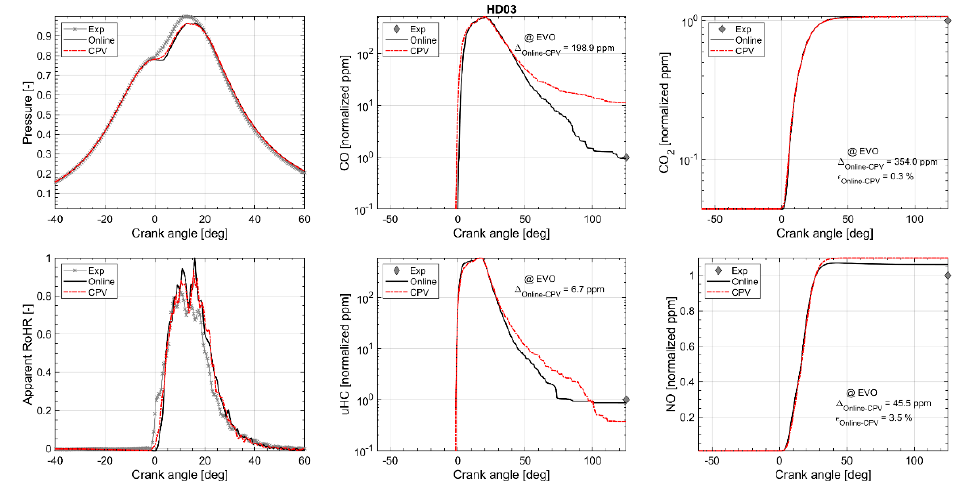
Figure A3. Engine performance and emissions for operating point HD03 (1300 rpm, 14.5 bar IMEP).